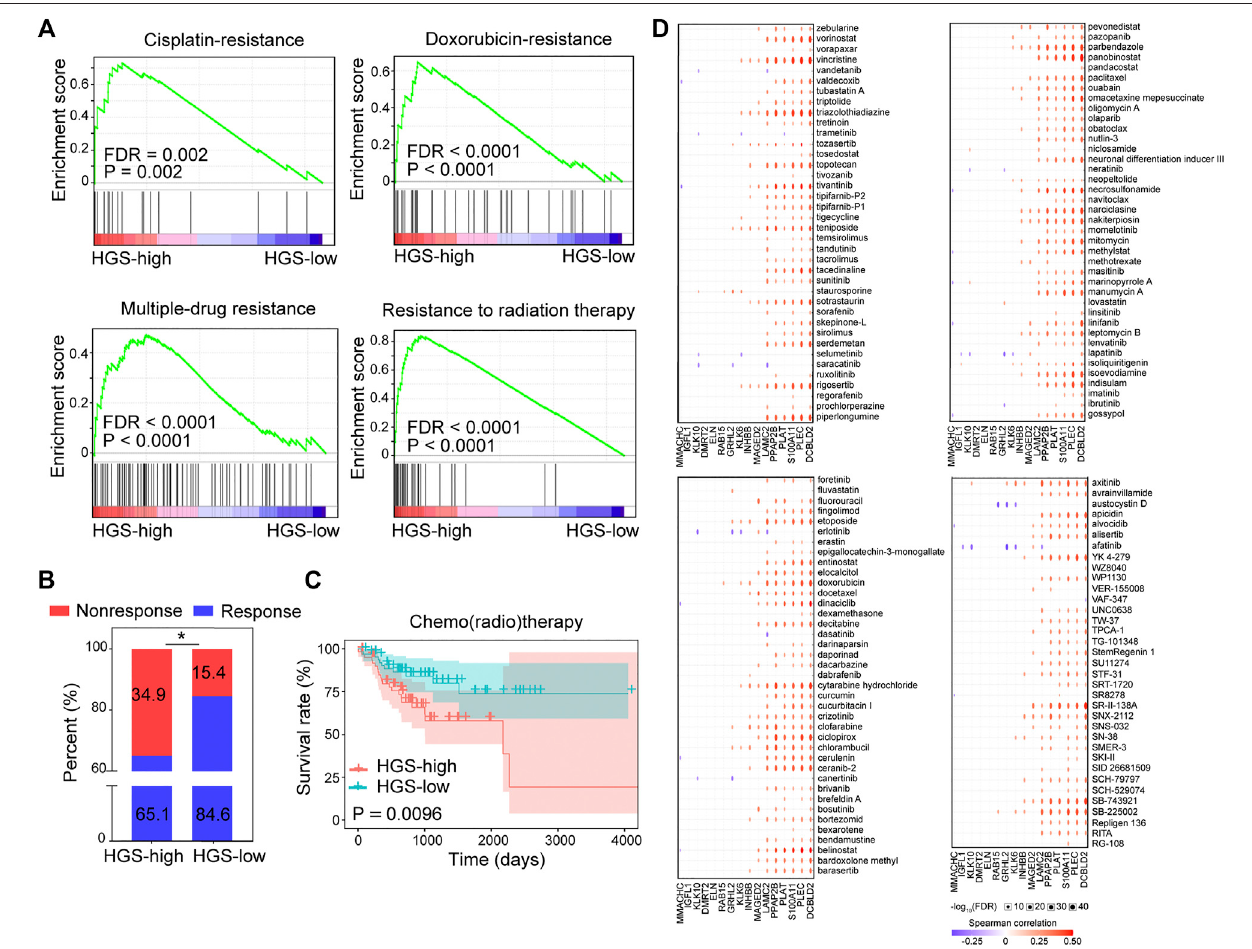
FIGURE 5 | The correlation between HGS and drug resistance. (A) GSEA of cisplatin-resistance, doxorubicin-resistance, multidrug-resistance, and resistance to radiation therapy pathways in HGS-high and HGS-low groups. (B) Comparison of CRC chemotherapy treatment response between HGS-high and HGS-low groups. (C) Kaplan – Meier RFS curves for patients in HGS-high and HGS-low groups. (D) Spearman correlation analysis between the 16 hypoxia genes and 151 chemo drugs.